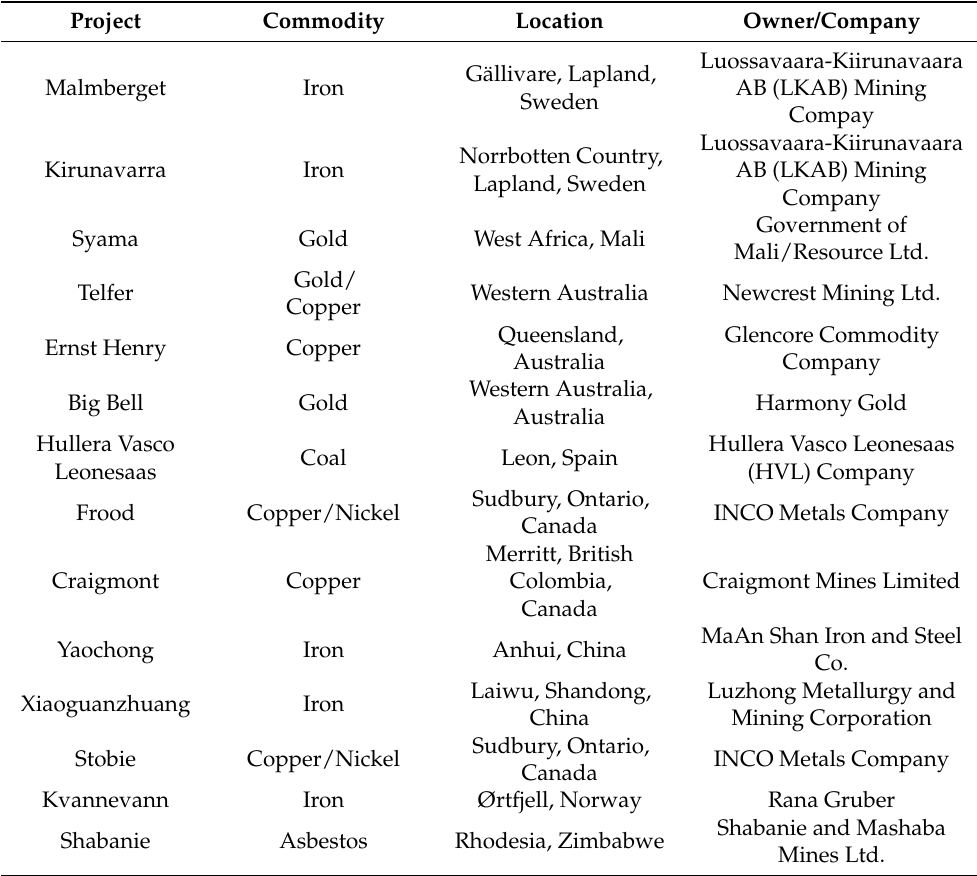
Table 1 represents the list of current mining projects utilizing the sublevel caving method in different parts of the world. Table 1. Current SLC projects in the